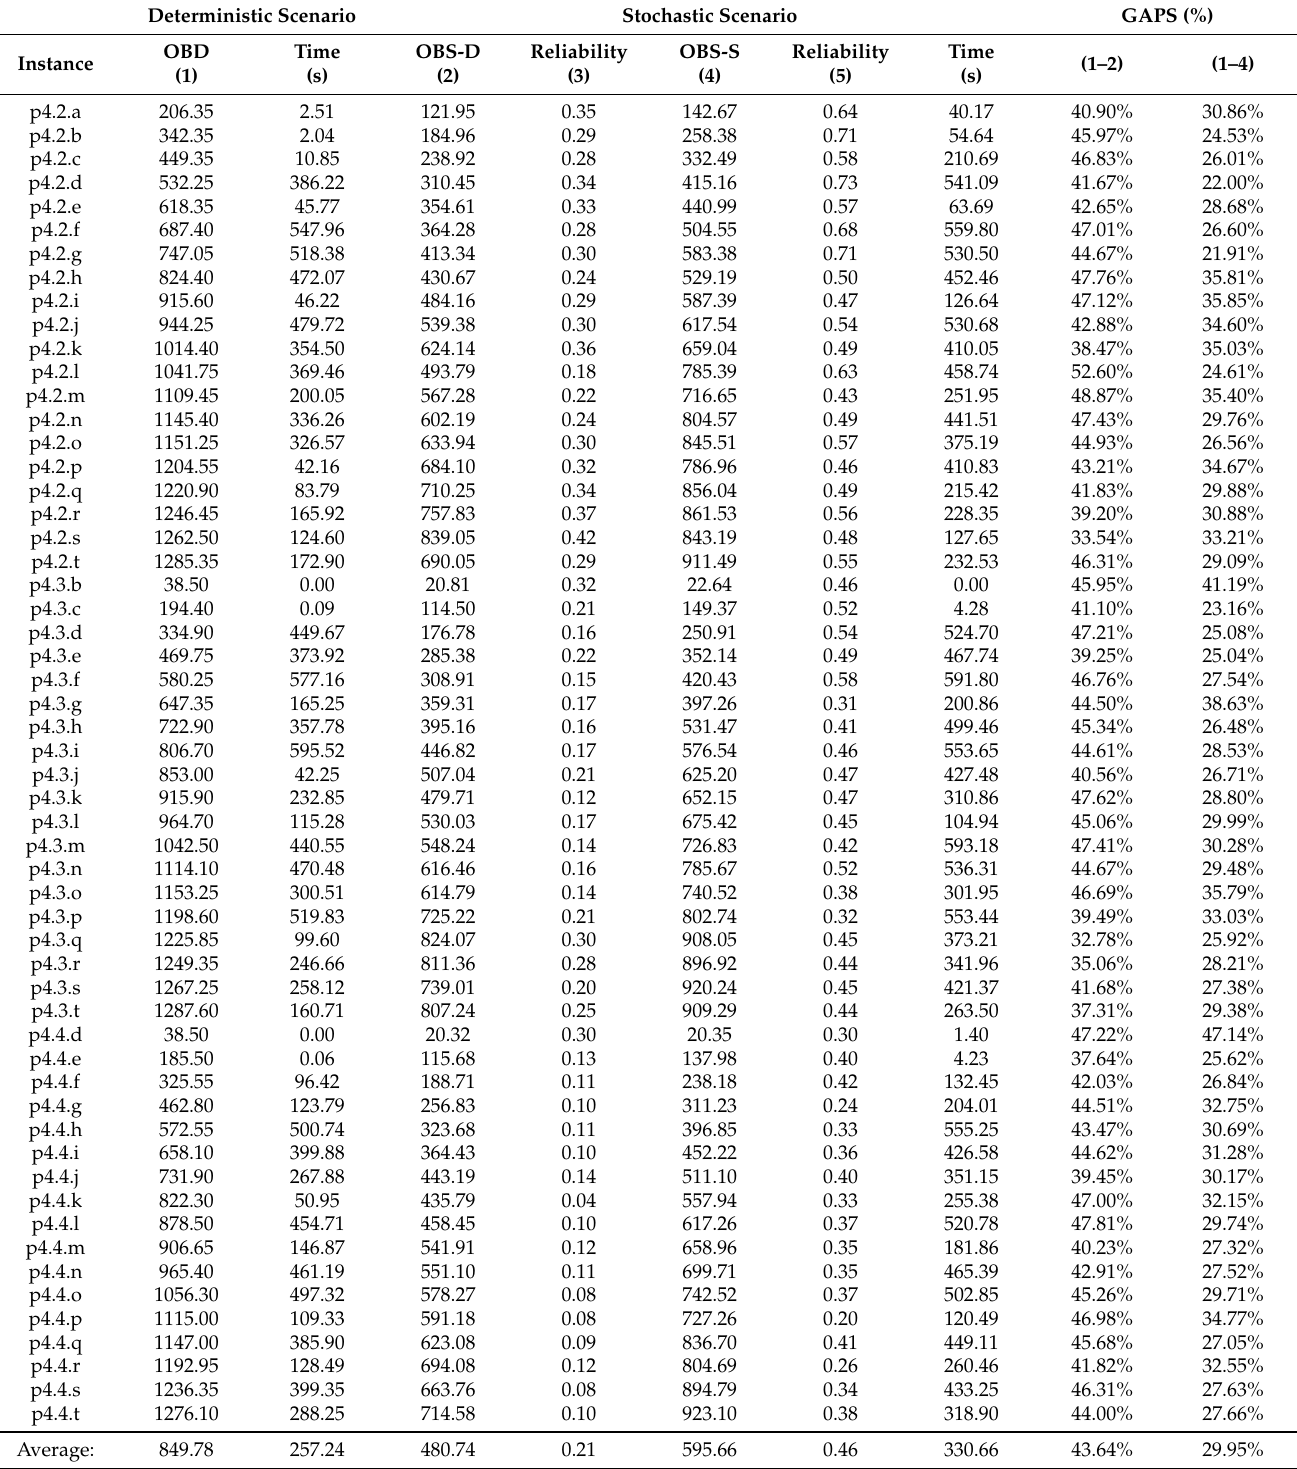
Table 9. Results for p 4 instances in a stochastic scenario with a high variance ( c =